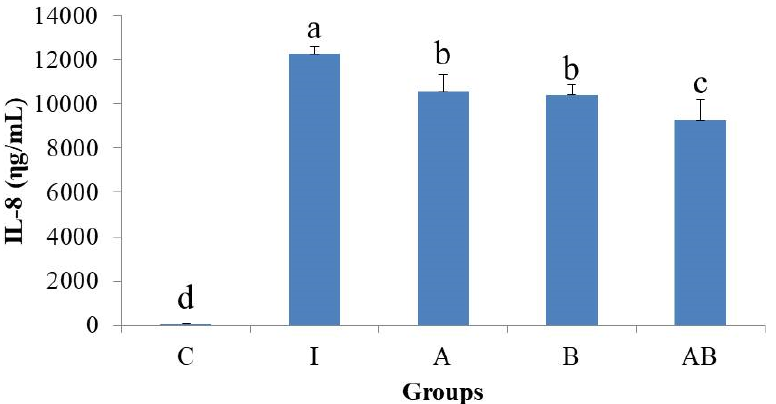
Figure 3. Effects of probiotics on IL-8 secretion in inflammatory HT-29 cells. All values except for control are mean ± SD (n = 3). Bars with the same letter are not significantly different from one another determined by Duncan’s multiple range test, p < 0.05. C, control; I, TNF- α (20 ng/mL) with lipopolysaccharide (LPS) (1 μ g/mL); A, L. acidophilus at MOI of 1 with TNF- α (20 ng/mL) and LPS (1 μ g/mL); B, B. animalis subsp. lactis at MOI of 10 with TNF- α (20 ng/mL) and LPS (1 μ g/mL); AB, L. acidophilus at MOI of 1 and B. animalis subsp. lactis at MOI of 10 with TNF- α (20 ng/mL) and LPS (1 μ g/mL).